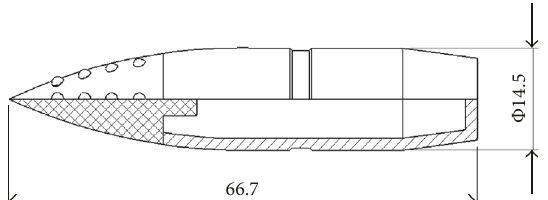
Figure 16: Structure of experiment